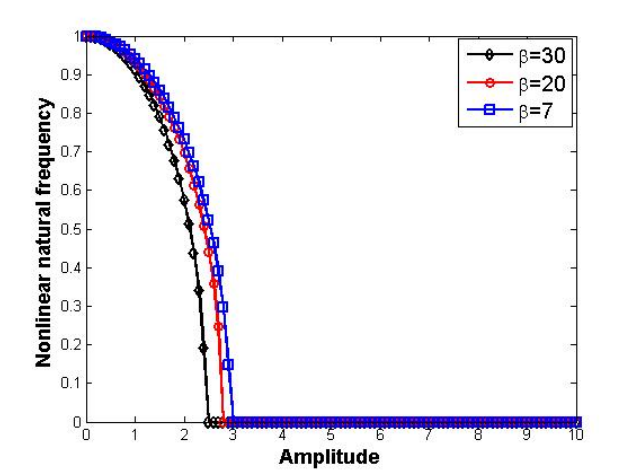
Figure 10. Influence of thickness variation on nonlinear natural frequency